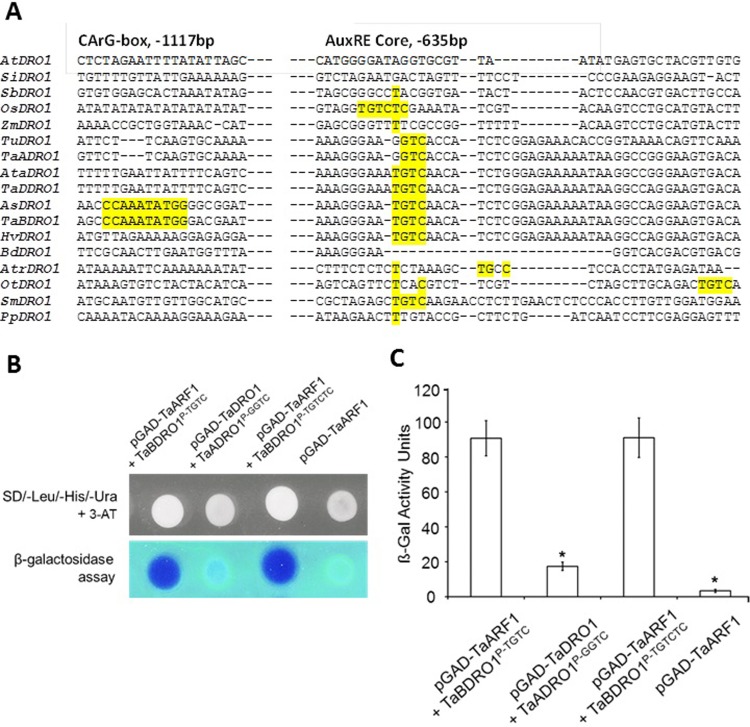
ARF1 binds more strongly with the AuxREs in the promoter region of TaBDRO1-like.(A) Multiple alignment of partial promoter sequence of DRO1-like orthologs from 17 different plants is shown (right panel). The conservation of AuxRE core motif (right panel) and upstream N10–like CArG-boxes (left panel) is depicted. Nucleotides marked as yellow indicate the standard TGTCTC motif and TGTC as core near the TSS while nucleotides underlined as yellow represent the N10-like CArG-box which is a binding site for MADS-box transcription factors. B) Yeast 1-hybrid analysis was performed for the detection of binding of ARF1 with cis-DNA fragments of TaDRO1-like (upper panel). The lower panel indicates non-lethal β-galactosidase assay. (C) Calculations of β-galactosidase activity of binding of ARF1 with AuxREs (TGTCTC and TGTC) of TaDRO1-like. * Significant (P<5%).